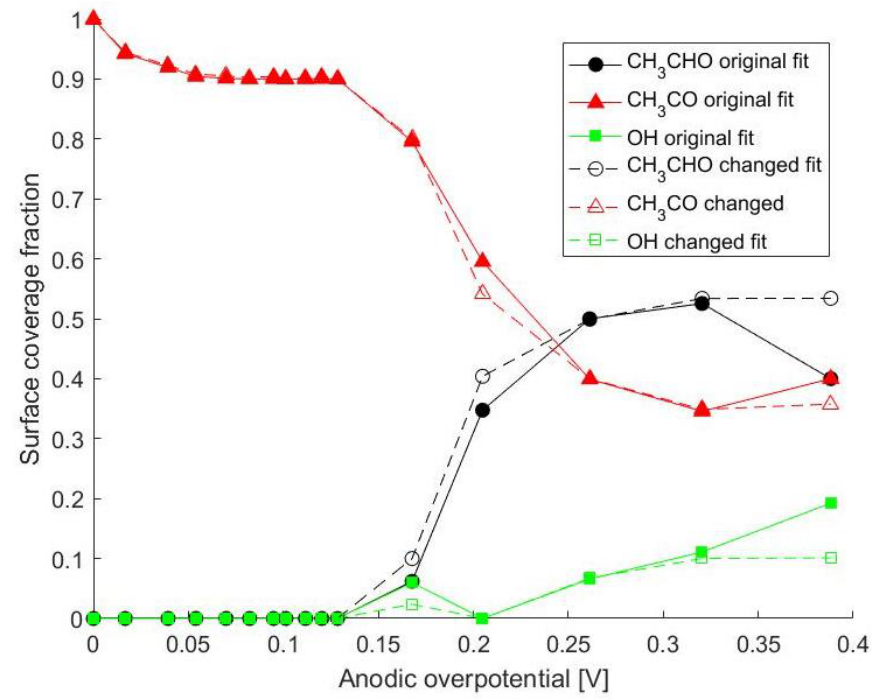
Figure 4. Surface coverage fraction distributions for PtSn 3 , original and changed fit.